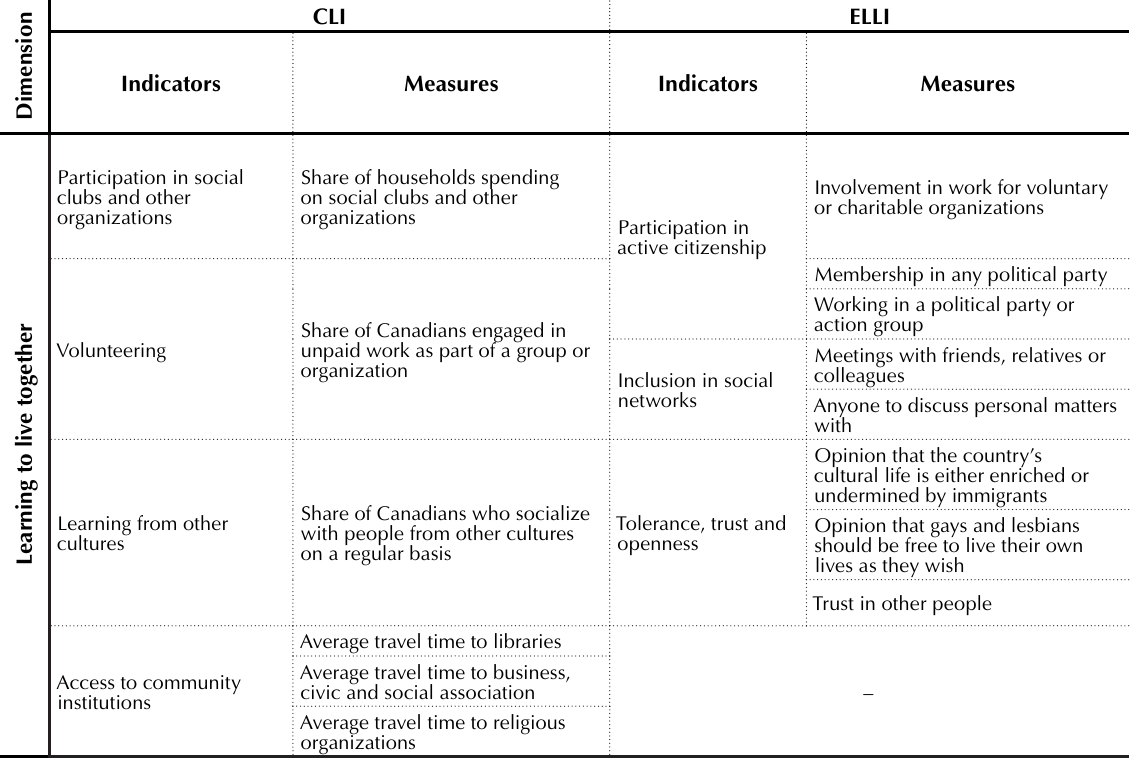
Table A3. The dimension of learning to live together Source: Developed by authors on the basis of the 2010 Composite Learning Index (2010) and Hoskins, Cartwright, and Schoof (2010).